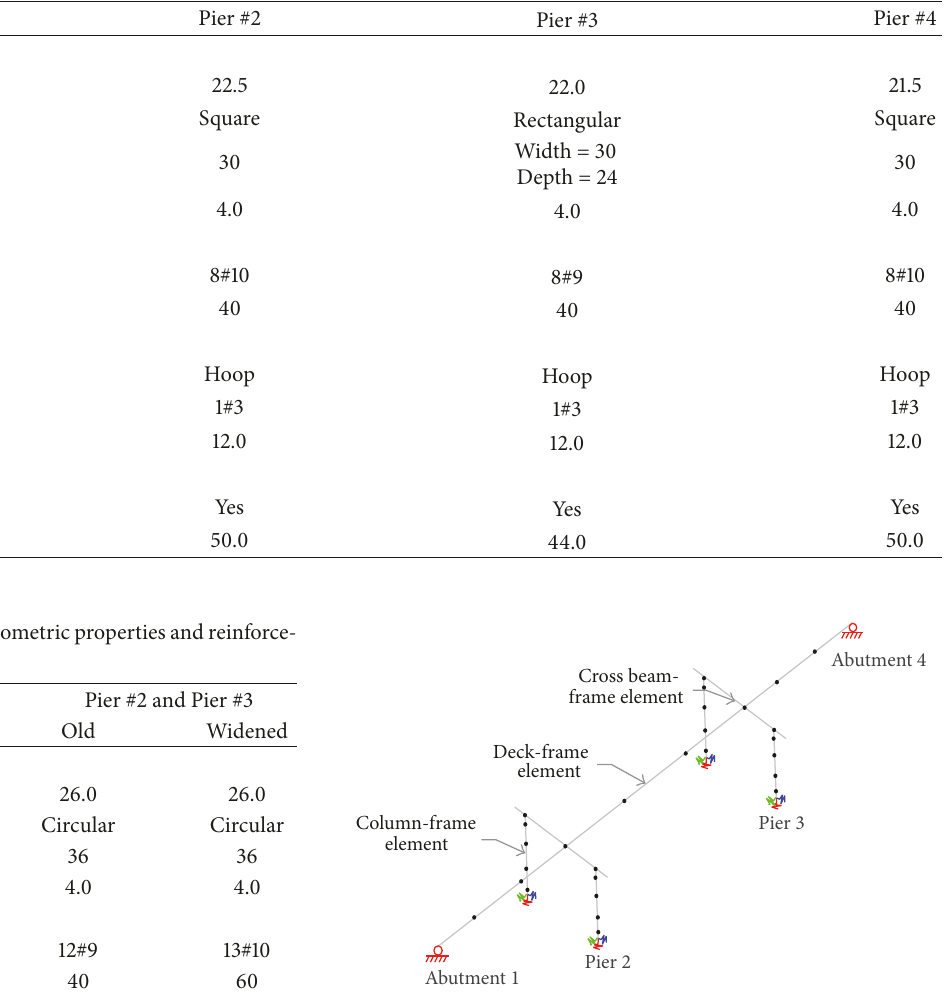
Figure 1: Three-dimensional model of Bridge